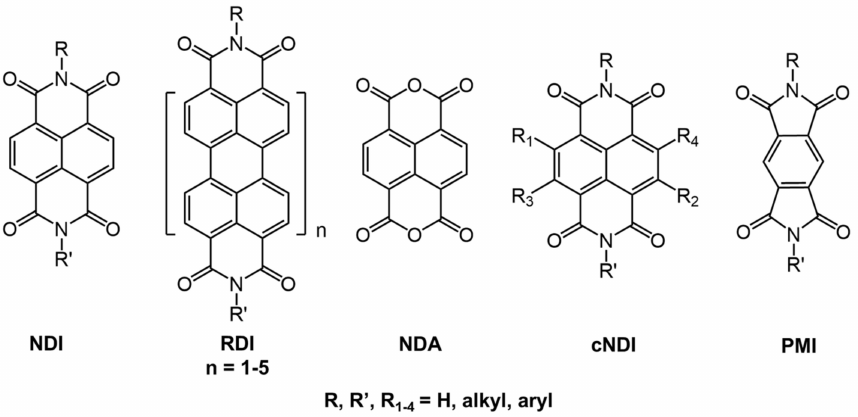
Figure 10. Structure of naphthalene diimide (NDI) and derivatives of it with potential photophysical, self-assembly, and functional properties. Reprinted (adapted) with permission from [67]. Copyright (2016) American Chemical Society.